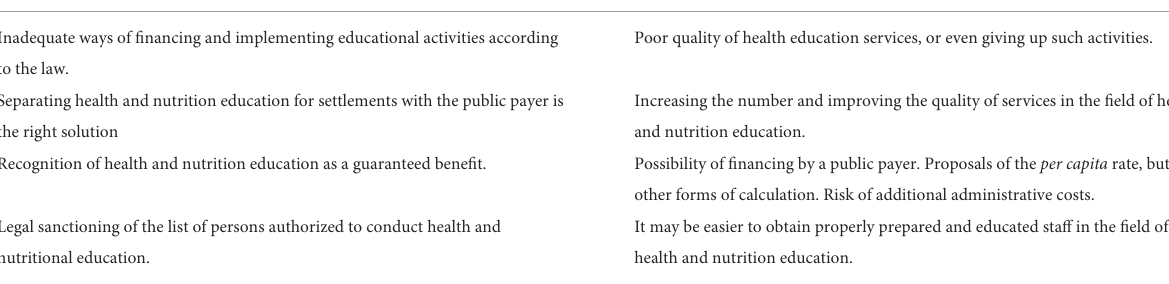
TABLE 1 Opinions and observations of experts in the field of legal regulations. Opinions and observations of experts